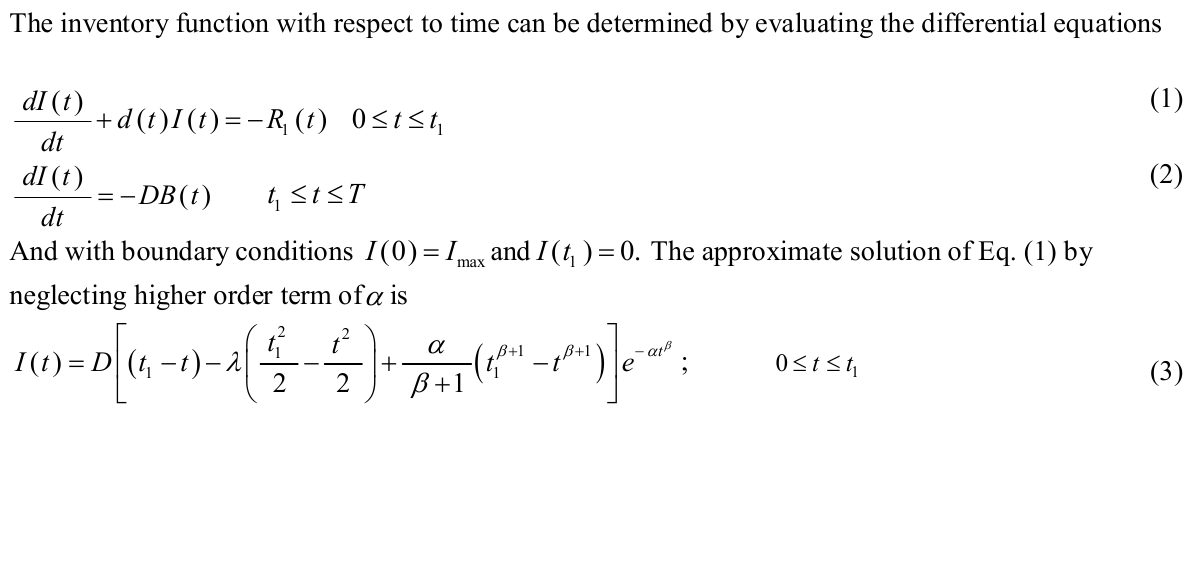
Fig. 1. Inventory system of decaying item for declining market